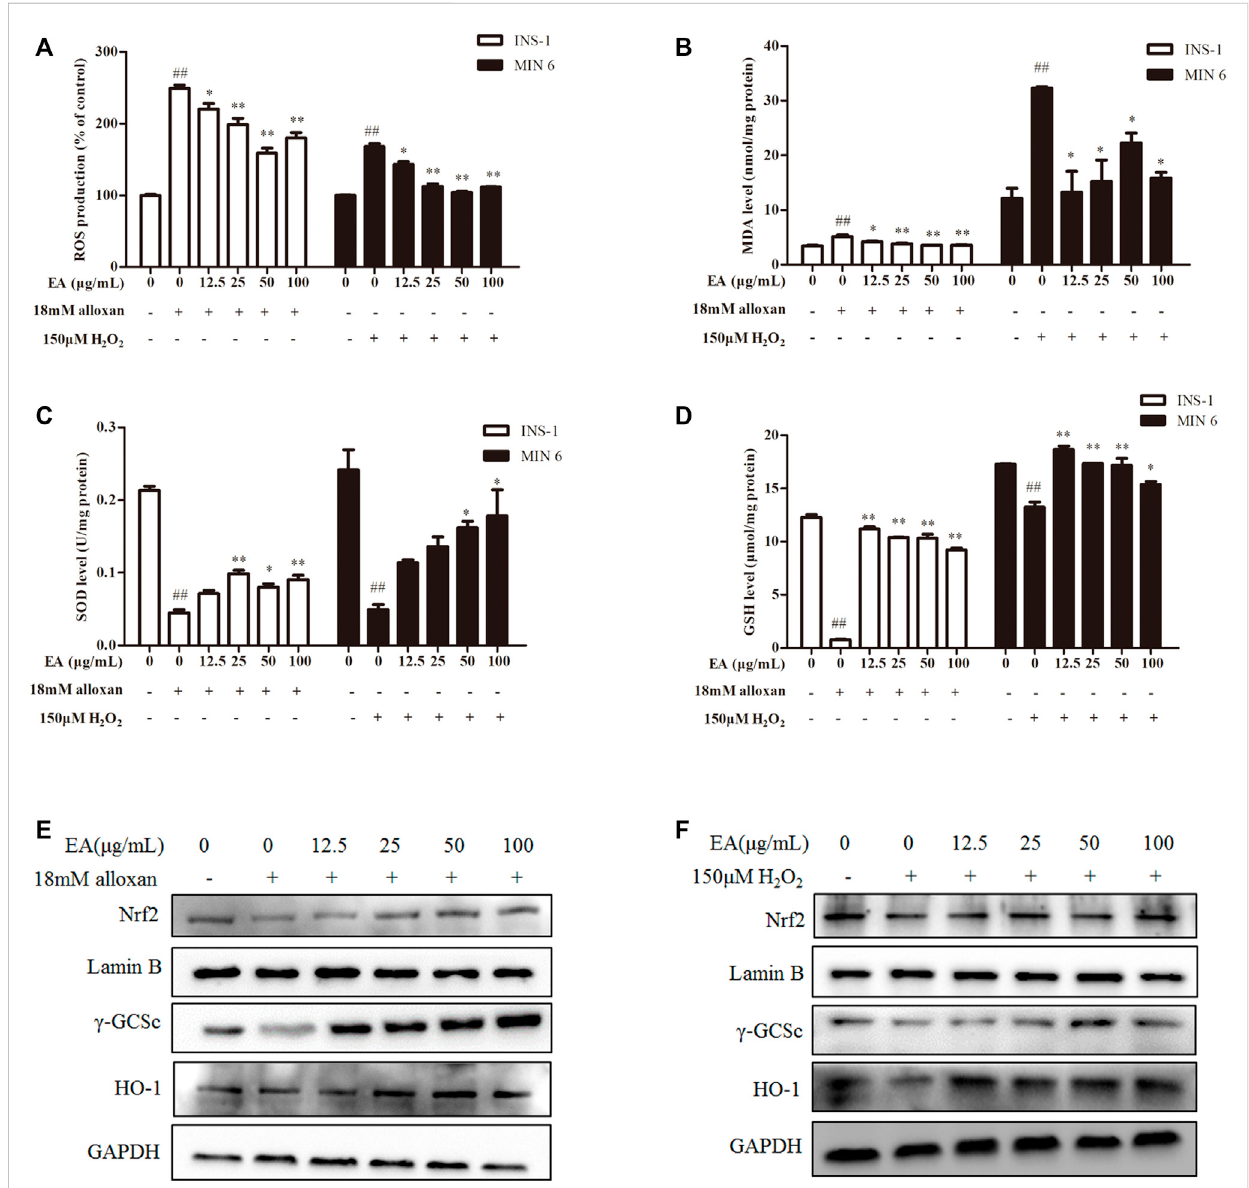
FIGURE 2 EA protects β cells from oxidative stress damage. INS-1 cells were incubated with EA (12.5 – 100 μ g/mL) and alloxan for 24 h, MIN6 cells were incubatedwithEA(12.5 – 100 μ g/mL)andH 2 O 2 for24 h.Levelsofoxidativestress-relatedmakersweredetermined. (A) Analysisofthemean fl uorescence intensity of DCF (indicator of reactive oxygen species). Effect of EA on MDA production (B) , SOD activity (C) , and on the level of reduced GSH (D) in oxidative stress-treated β cells. (E,F) Protein expression of Nrf 2, γ -GCSc, and HO-1 of alloxan (18 mM)-treated cells (E) and H 2 O 2 (150 μ M)-treated cells (F) was measured by western blotting. Data are the mean ± SEM (n = 3). # p < 0.05 compared with control, ## p < 0.01 compared with control, * p < 0.05 compared with the OS-model group, ** p < 0.01 compared with the OS-model